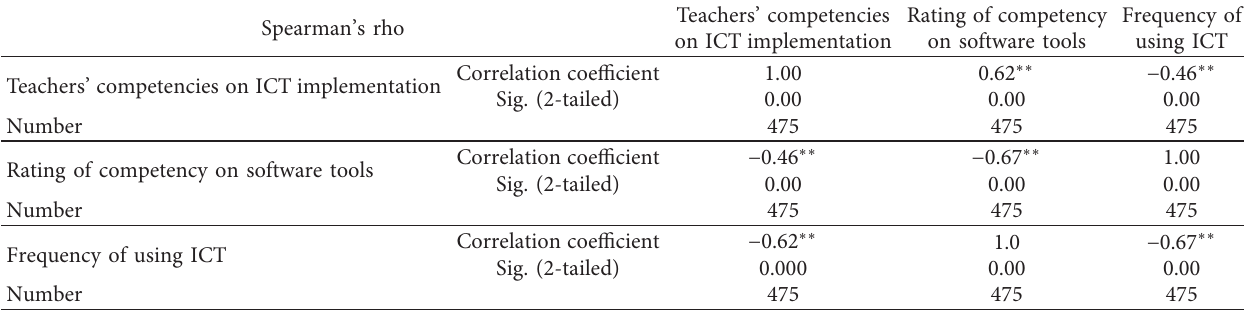
Table 4: Correlation table for teachers’ competencies on ICT implementation.